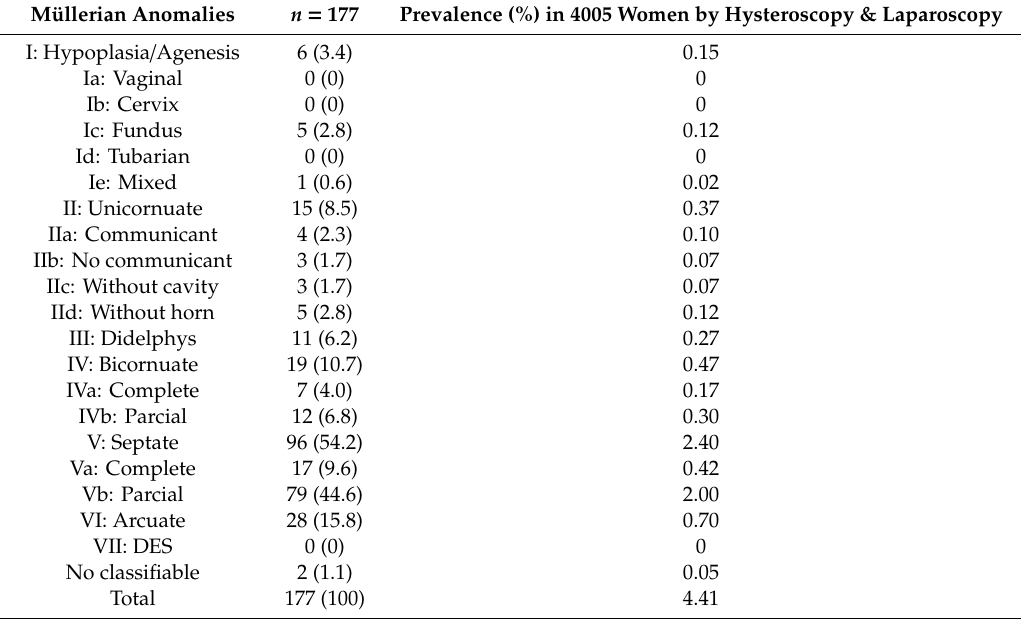
Table 2. Absolute frequency of Müllerian anomalies according to the ASRM classification. Müllerian Anomalies n = 177 Prevalence (%) in 4005 Women by Hysteroscopy & Laparoscopy